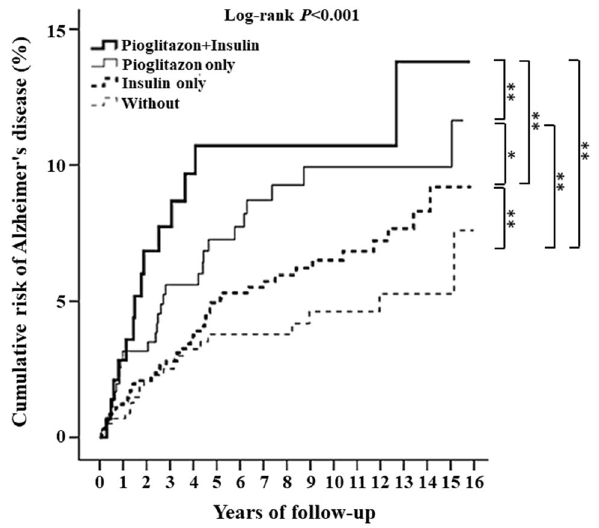
Figure 3. Kaplan–Meier plot for cumulative incidence of AD in T2DM patients without or with pioglitazone plus insulin, pioglitazone alone, or insulin